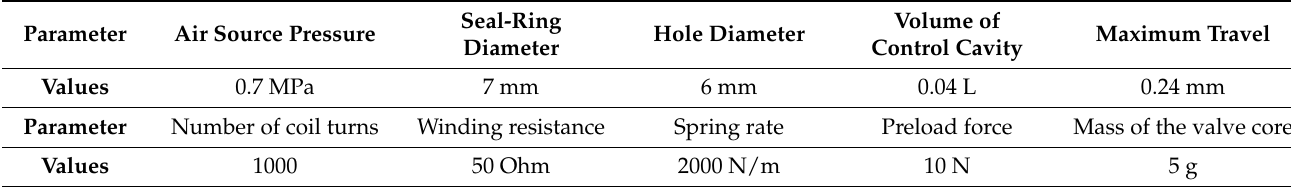
Table 5. Main structural parameters of the simulation model for the pressure regulation characteristics of the APRV of different structural configurations in the ECPBS of commercial